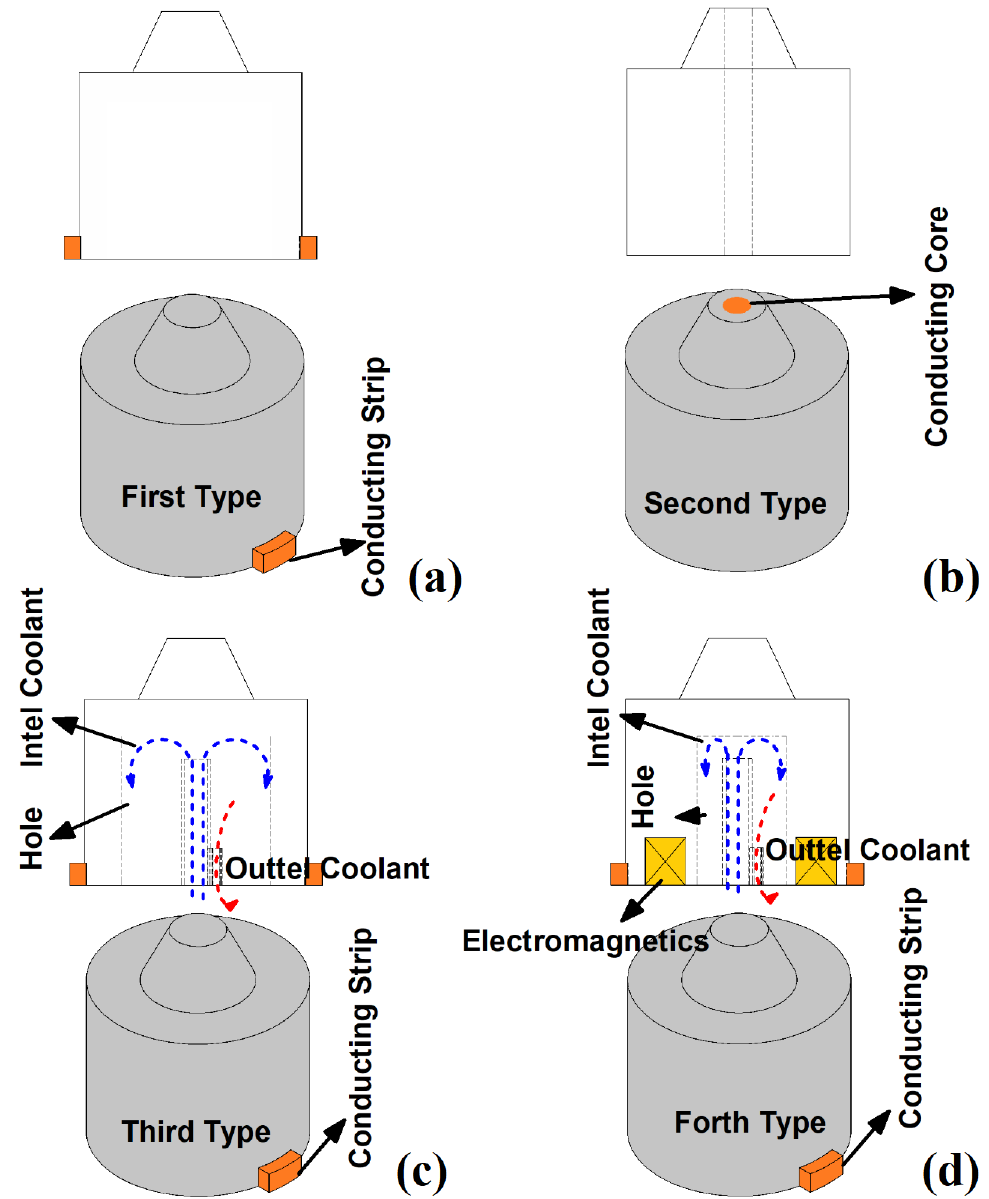
Figure 2. EA-FSW Tools, ( a ) Type a, ( b ) Type b, ( c ) Type c, and ( d ) Type d.